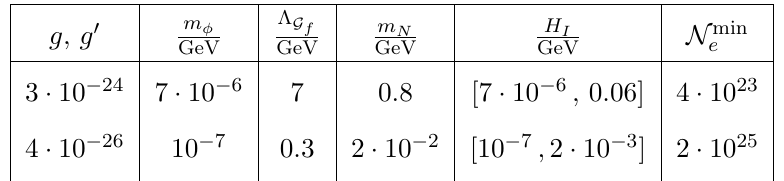
Table 3 . Numerical values of the parameters for two benchmark points. For the (cid:12)rst line, we set (cid:3) IR = 4 (cid:1) 10 3 TeV, y = 2~ y = 0 : 2 and m L = 700 GeV, while for the second line, (cid:3) IR = 500 TeV, y = 2~ y = 0 : 04 and m L = 450